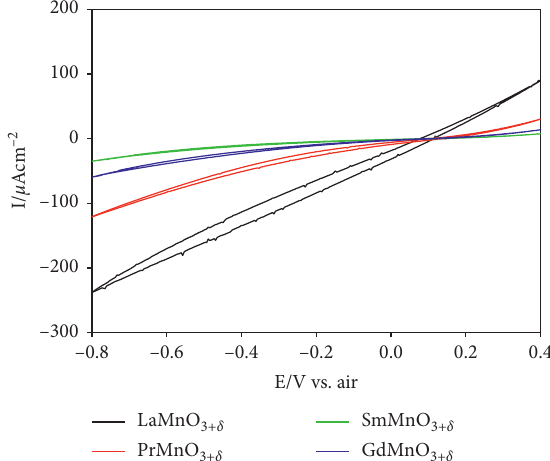
Figure 3: Four voltammograms recorded at 300C in 10% O with a sweep rate of 1mV/s. Again a marked difference is seen as a function of the A-site cation. The LaMnO 3+ δ perovskite is the most active compound for both oxygen evolution and oxygen reduction, whereas the PrMnO 3+ δ perovskite is the one with the lowest activity.